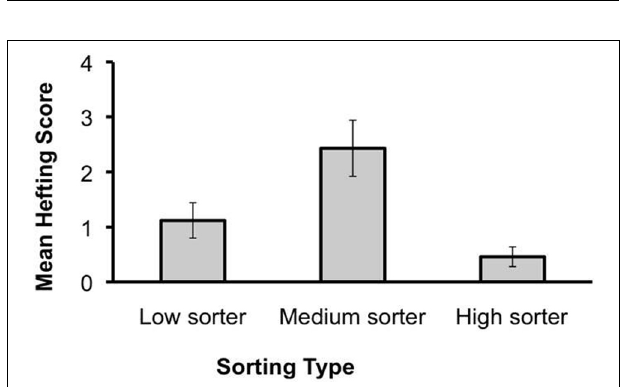
FIGURE 3 | Mean hefting score ( (cid:6) SE) as a function of sorting